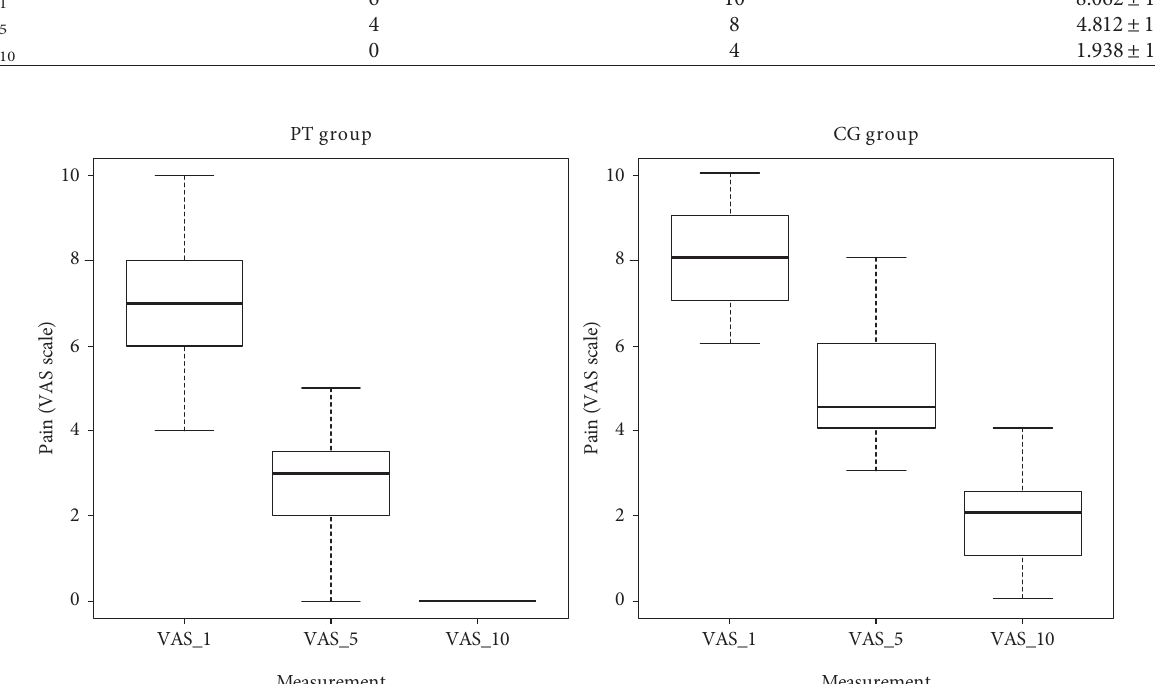
Figure 3: Reduction in pain intensity after physiotherapy treatments with ELF EMF and LED (PT group vs CG group).